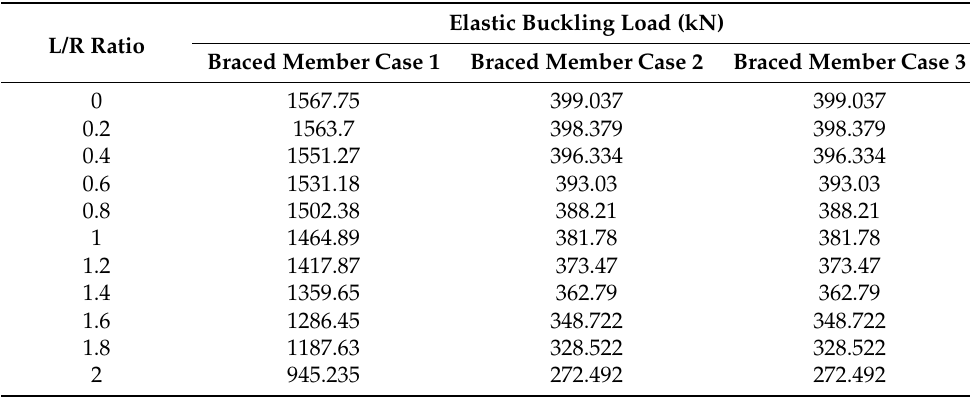
Table 14. The elastic buckling loads for sway